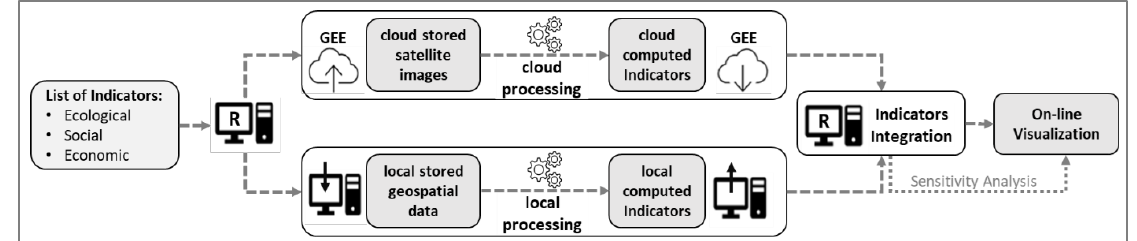
Figure 1. Diagram representing the main processes implicated in generating the prioritization of areas for restoration in the RePlant alpha platform.